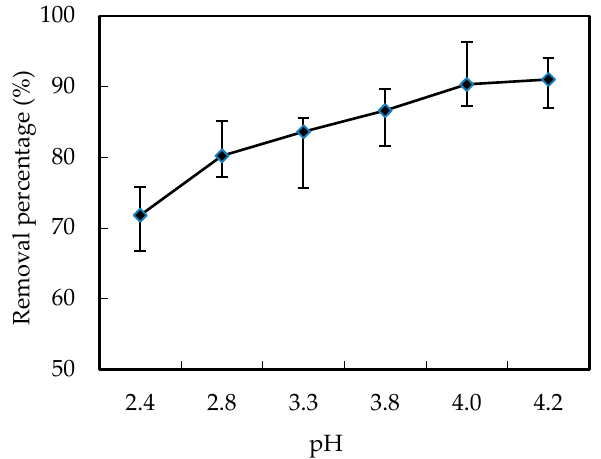
Figure 2. Effects of the pH of the feeding solution on the removal efficiency of W (VI).